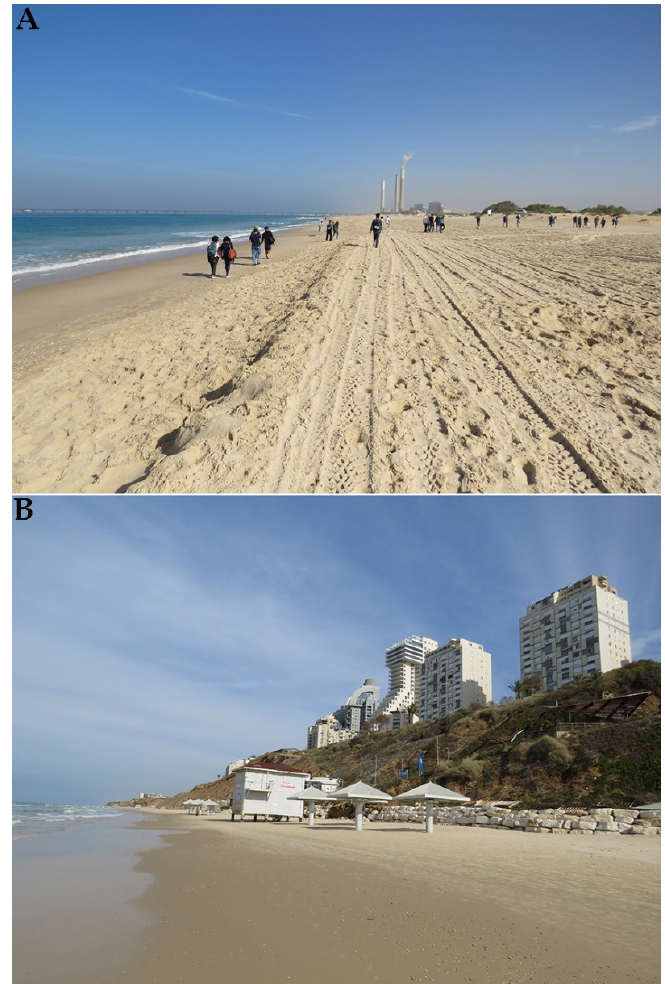
Figure 3. Fine quartz sand beach: (1) typical wide beach—for example, in Ziqim (the Southern coast) (( A ), photograph by Dov Zviely 16 November 2017). (2) Typical narrow beach—for example, in Netanya (the Sharon coast) (( B ), photograph by Dov Zviely 5 January